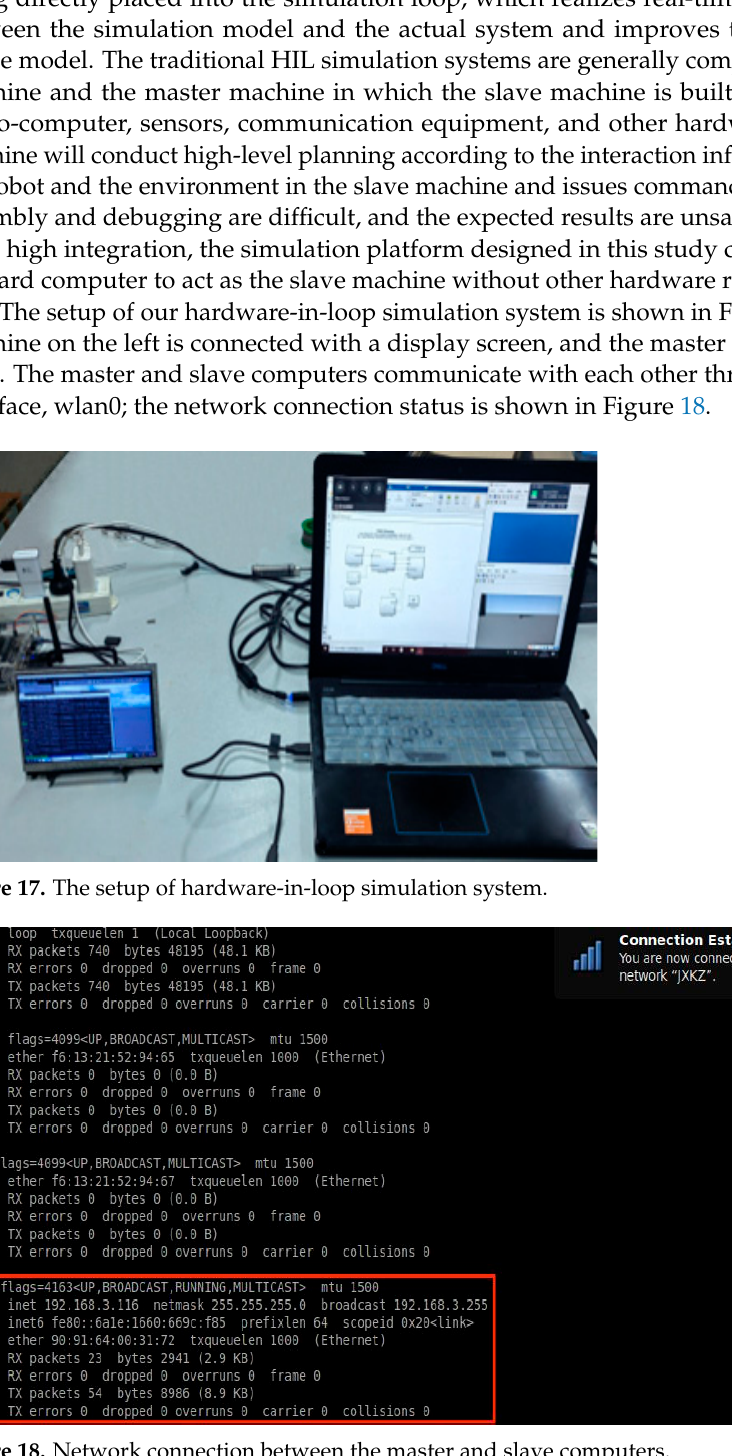
Figure 18. Network connection between the master and slave computers.